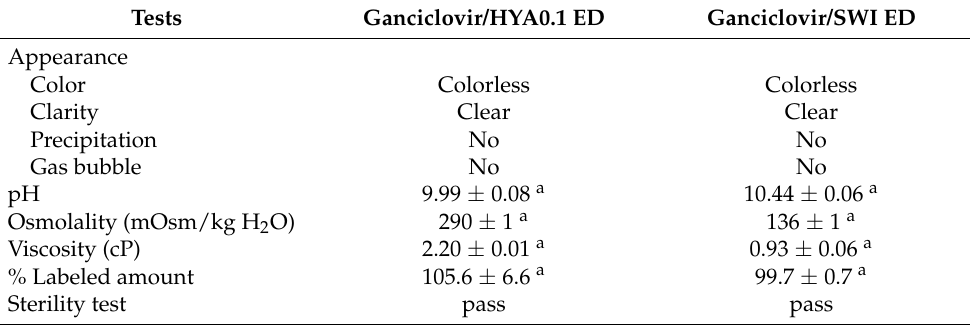
Figure 3. Examples of appearance of ( A ) 20 mg/mL ganciclovir/HYA0.1 ED and ( B ) ganciclovir/SWI ED after preparation. Table 4. Physicochemical and microbiological properties of 20 mg/mL ganciclovir/HYA0.1 and SWI EDs.